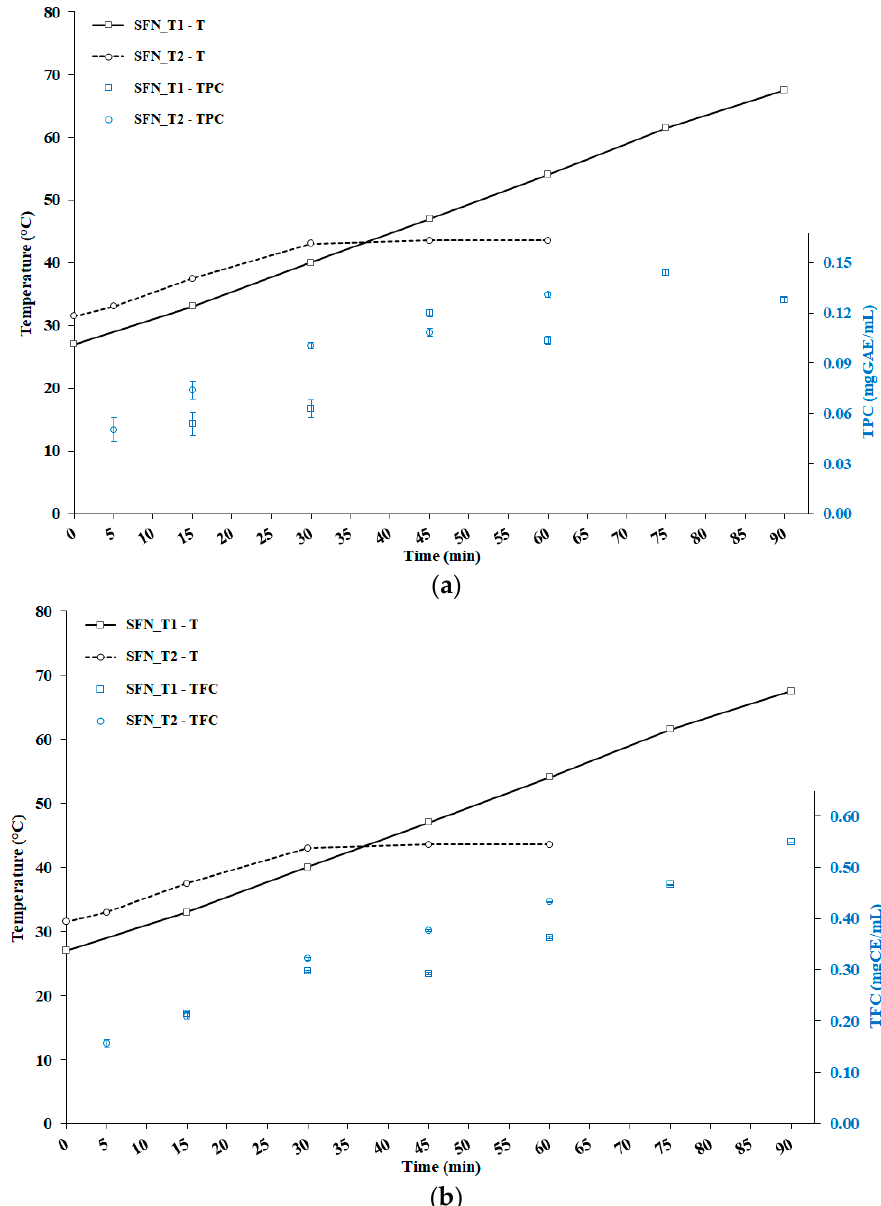
Figure 3. ( a ) Joint evolution of temperature (T) and total phenolic content (TPC) for tests SFN_T1 (Silver Fir Needles—Test 1) and SFN_T2 (Silver Fir Needles—Test 2); ( b ) Joint evolution of temperature (T) and total flavonoids content (TFC) for tests SFN_T1 and SFN_T2. Error bars represent the standard deviations.